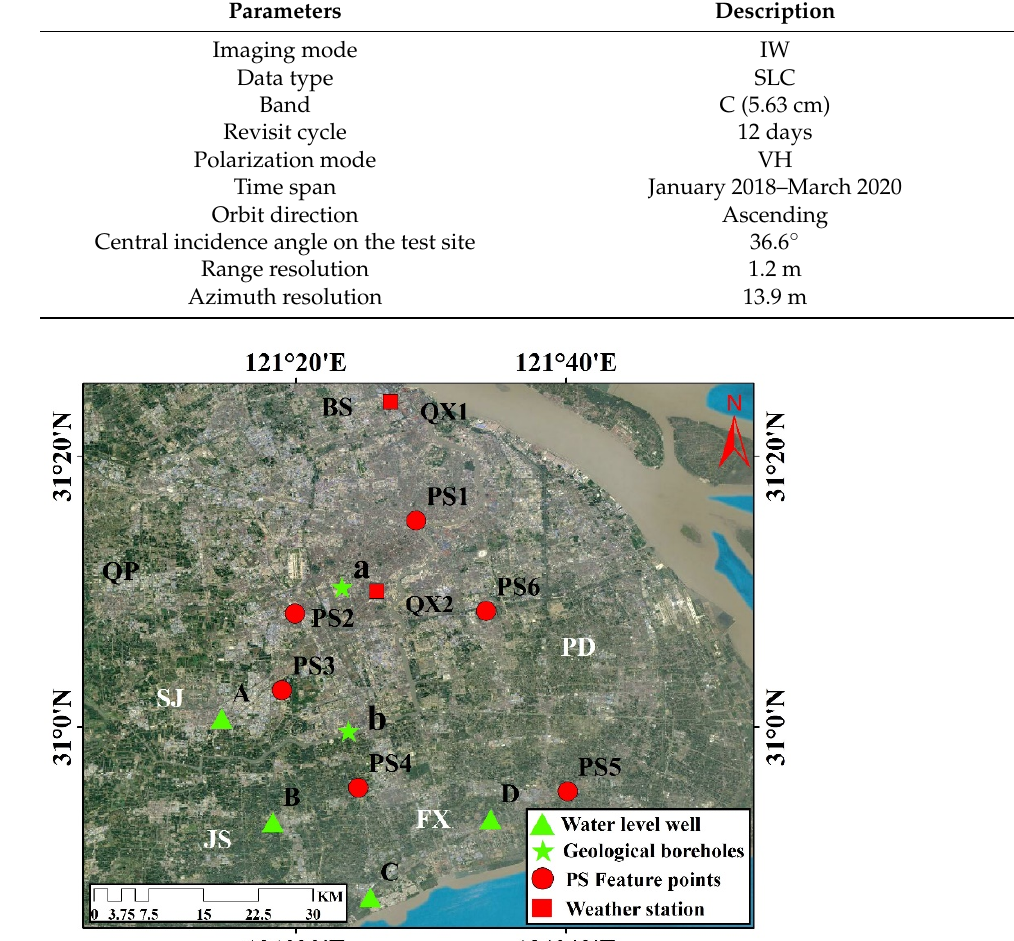
Table 2. Specific parameters of Sentinel-1A SAR images.